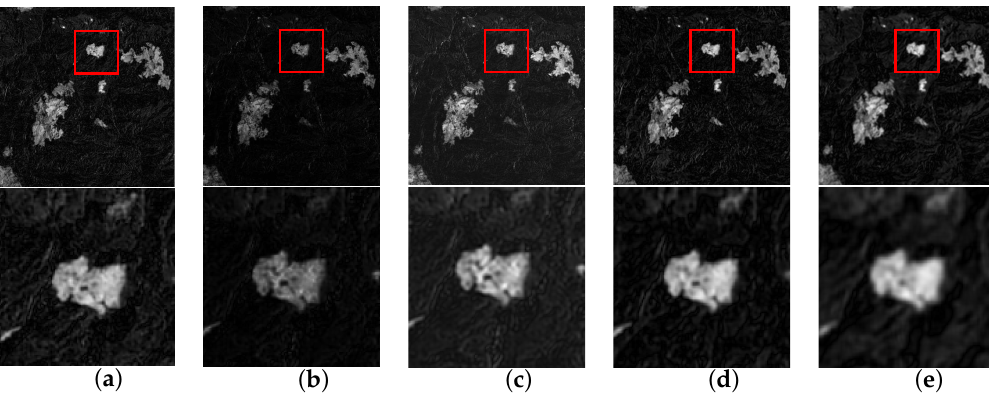
Figure 14. The DIs generated by different methods in the Mexico data set: ( a ) subtraction, ( b ) log-ratio, ( c ) wavelet fusion, ( d ) SCCN, and ( e ) DADNN. The first row shows the full DI and the second row a zoomed-in region.